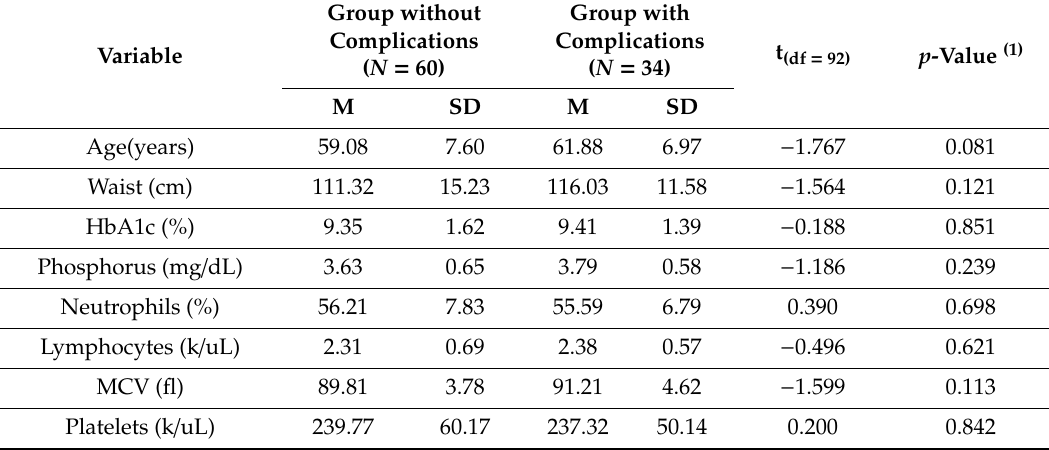
Table 1. Classification of physical chemistry parameters in patients with type 2 diabetes due to cardiovascular complications. Frequency analysis of quantitative variables. Parametric analysis with the t-student